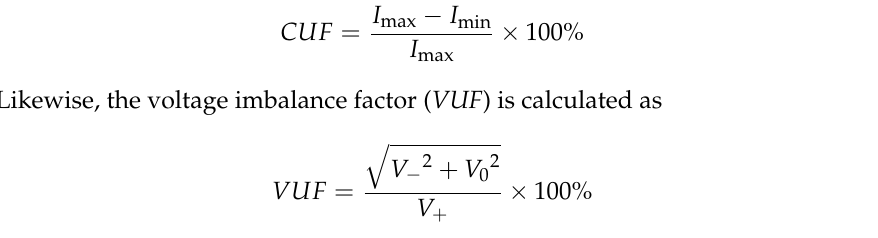
Figure 2. The schematic of neutral voltage shift.